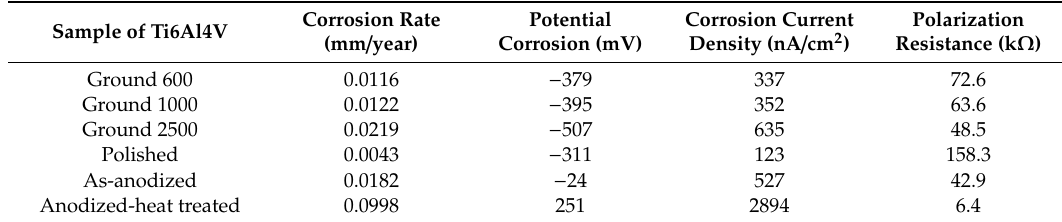
Table 2. Results of corrosion tests at 37 °C in 0.9% NaCl solution for ground, polished, as-anodized, and anodized-heat treated surfaces.